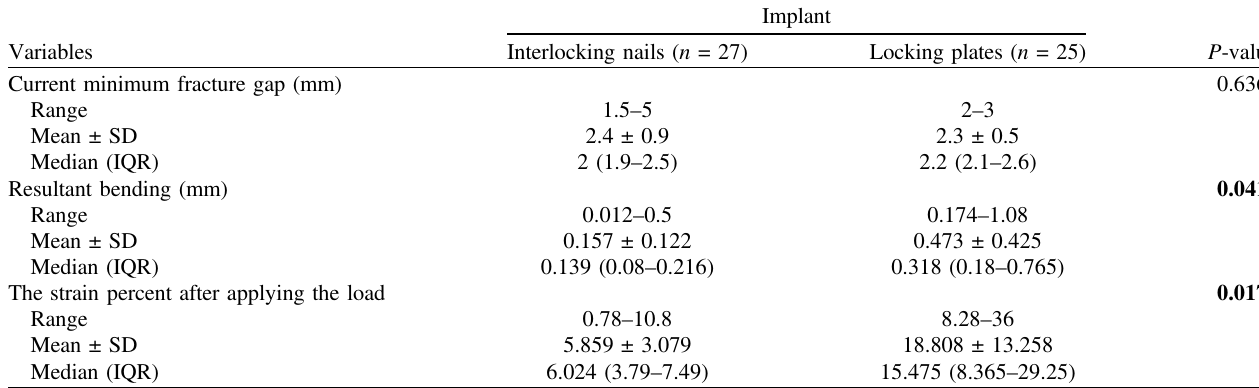
Values in bold are the statistically signi fi cant results. Table 3. The correlations between the type of implant and procedures measures.